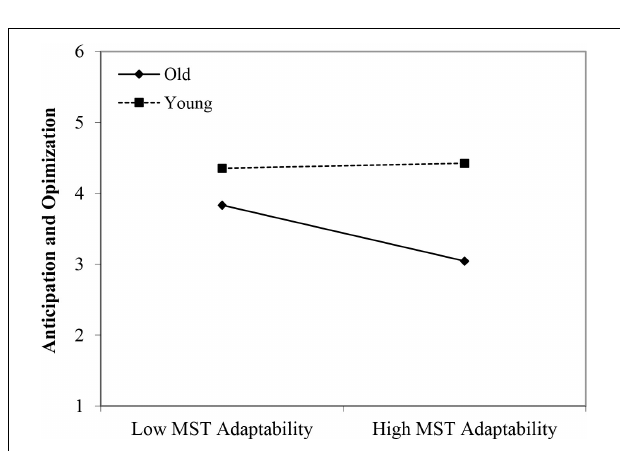
FIGURE 4 | Interaction between perceived age-based (meta-)stereotyping productivity and age groups: Predicting anticipation and optimization. Low = –1 SD , High = + 1 SD , MST = perceived age-based (meta-)stereotyping, old = older workers, young = younger workers.